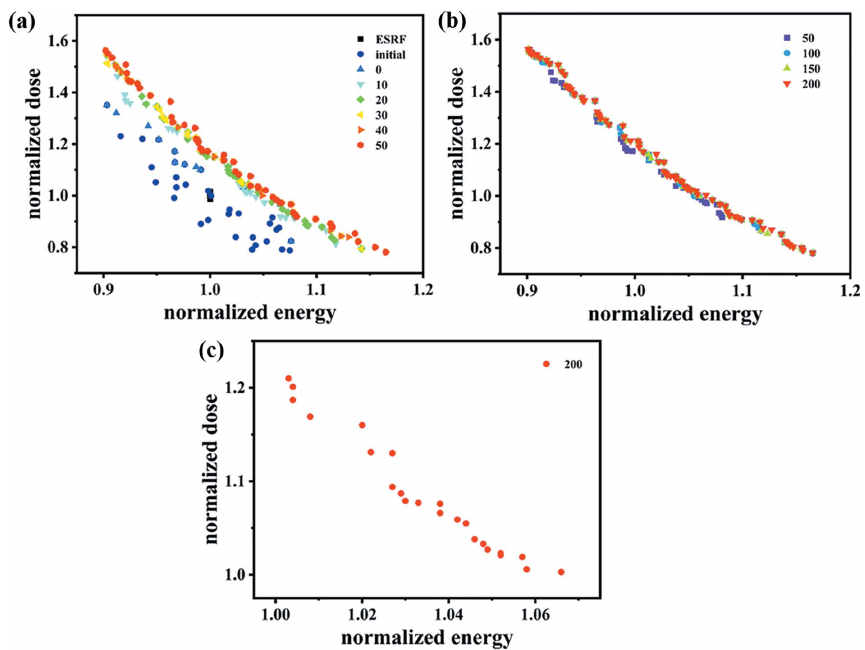
Figure 6 The results of the optimization simulation. ( a ) The solutions for ESRF are represented by the black squares and the initial populations are represented by purple circles as well as the Pareto front of the population with the generation number of 0, 10, 20, 30, 40 and 50. ( b ) The Pareto front of the population with the generation number of 50, 100, 150, 200. ( c ) The solutions of the last generation that are better than that of the ESRF.